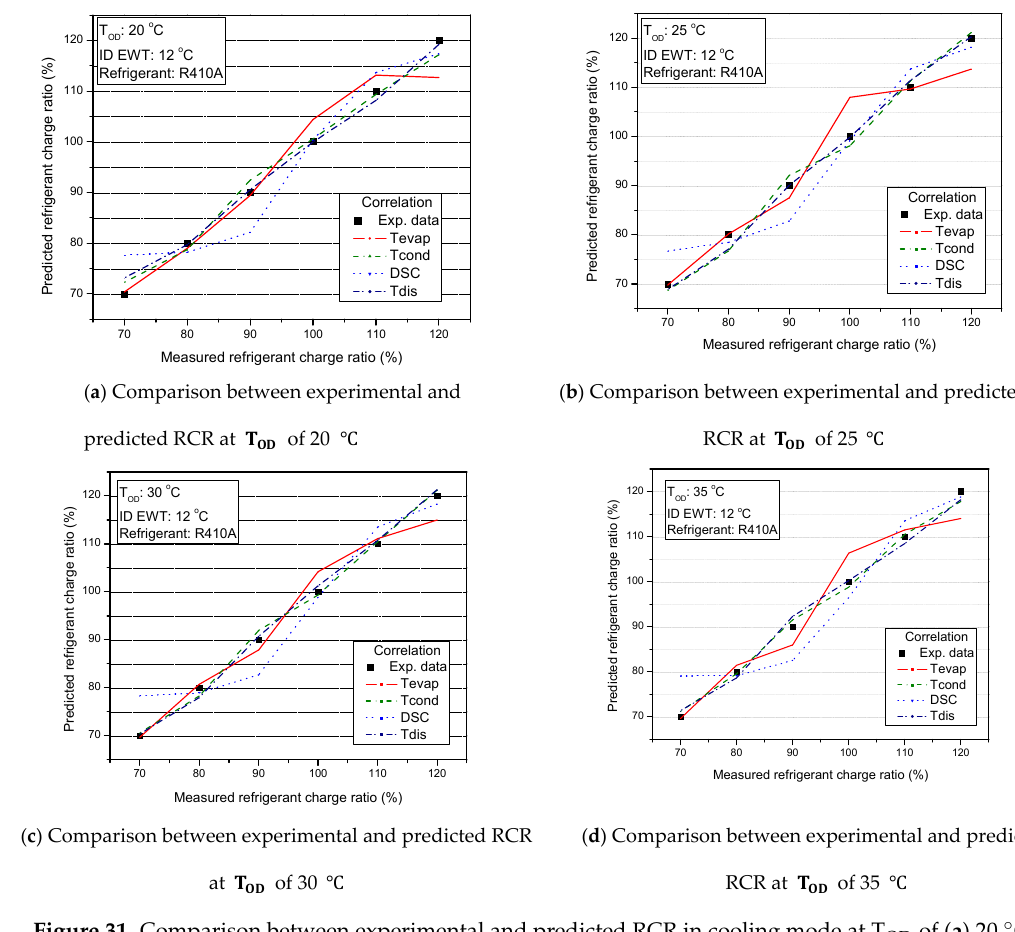
Figure 31. Comparison between experimental and predicted RCR in cooling mode at T OD of ( a ) 20 ◦ C, ( b ) 25 ◦ C, ( c ) 30 ◦ C and ( d ) 35 ◦ C. In cooling mode, the degree of subcooling model had the highest error threshold of ±11.9%, followed by the evaporating temperature model, with an error threshold of ±7.9%. The condensing temperature and compressor discharge temperature models had the lowest error thresholds in predicting the RCR of the heat pump. In heating mode, the degree of subcooling model had the highest error threshold followed by the condensing temperature model. The compressor discharge temperature and evaporating temperature models had the lowest error thresholds as shown in Table 6.